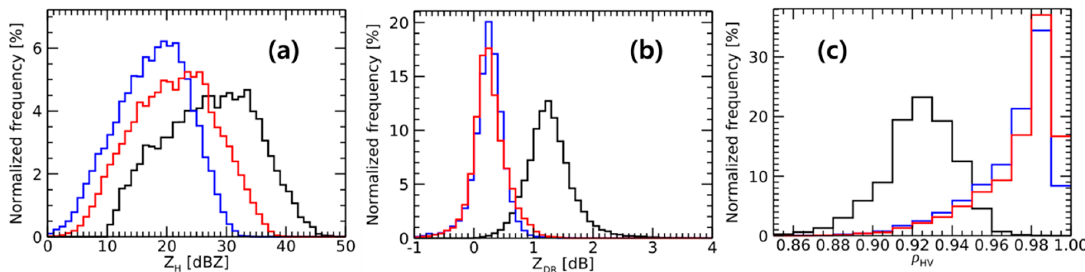
Figure 12. Normalized frequency distribution of ( a ) Z H , ( b ) Z DR , and ( c ) ρ HV at top (blue), peak (black), and bottom (red) of the BB.